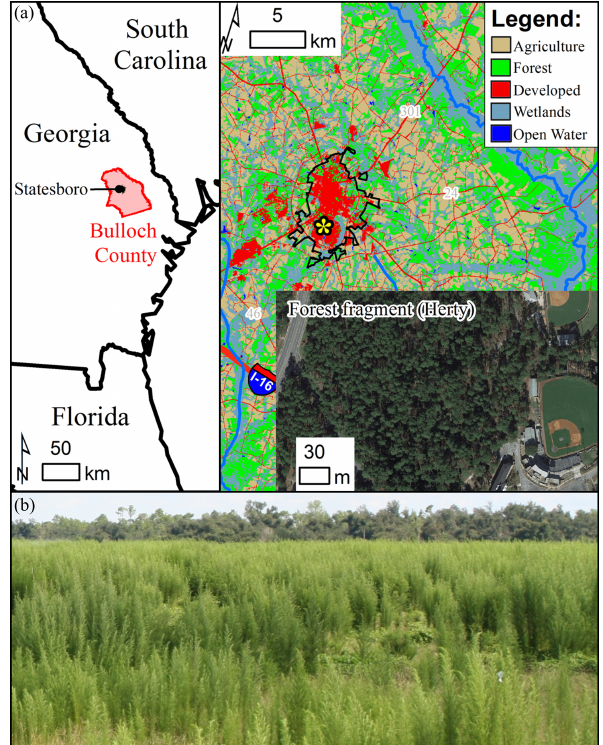
Figure 2. (a) Location of the studied Pinus palustris (longleaf pine) forest fragment, Charles H. Herty Pines Nature Preserve, on the Statesboro, Georgia (USA), campus of Georgia Southern Univer- sity, where Eupatorium capillifolium (dogfennel) is a dominant un- derstory plant. (b) Dogfennel can dominate pastures as well, as shown by the photograph (credit: Brent A. Sellers). The map lay- ers were sourced from state and county boundaries and aerial im- agery ©Esri, TomTom North America, Inc. The land use layer was derived from the National Land Cover Database 2011 (full meta- data and data access link: https://gdg.sc.egov.usda.gov/Catalog/ ProductDescription/NLCD.html, last access: 22 July